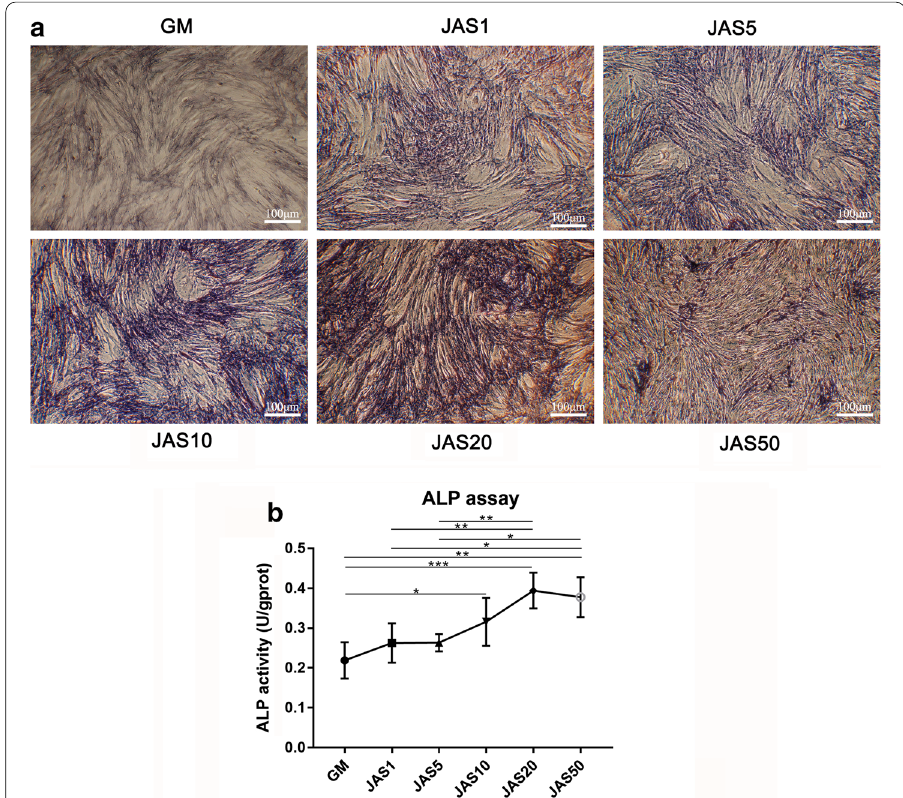
Fig. 6 Effects of different actin polymerization states on ALP activity in hASCs. a ALP staining of hASCs after treatment with JAS for 7 days; b Analysis of ALP activity of hASCs after treatment with JAS for 7 days. Values are mean SD; *p < 0.05. Scale bar 100 ± =